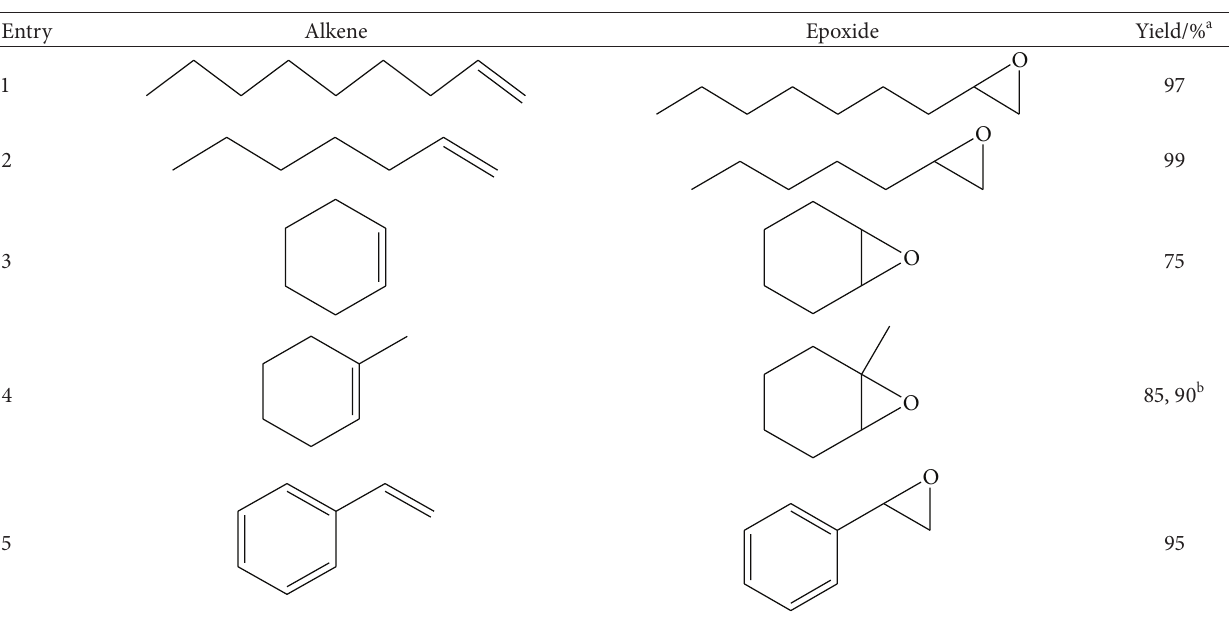
Table 1: Novozym 435-mediated epoxidation of alkenes.